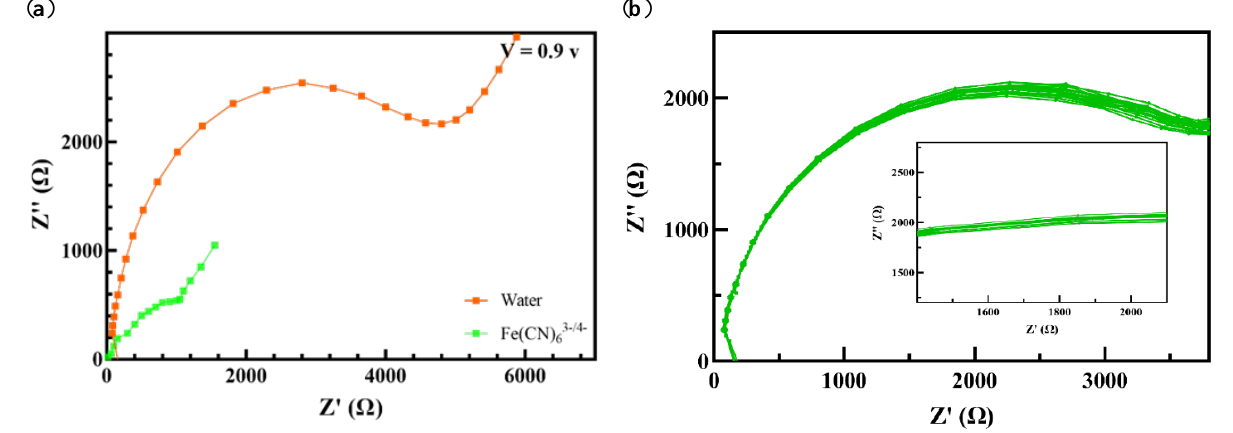
Figure 2. ( a ) The Nyquist spectra of electro-synthesized PAni in the electrolyte and in water for Fe (III) at V = 0.9 v. ( b ) The relative change in the impedance of the sensor after 25 consecutive